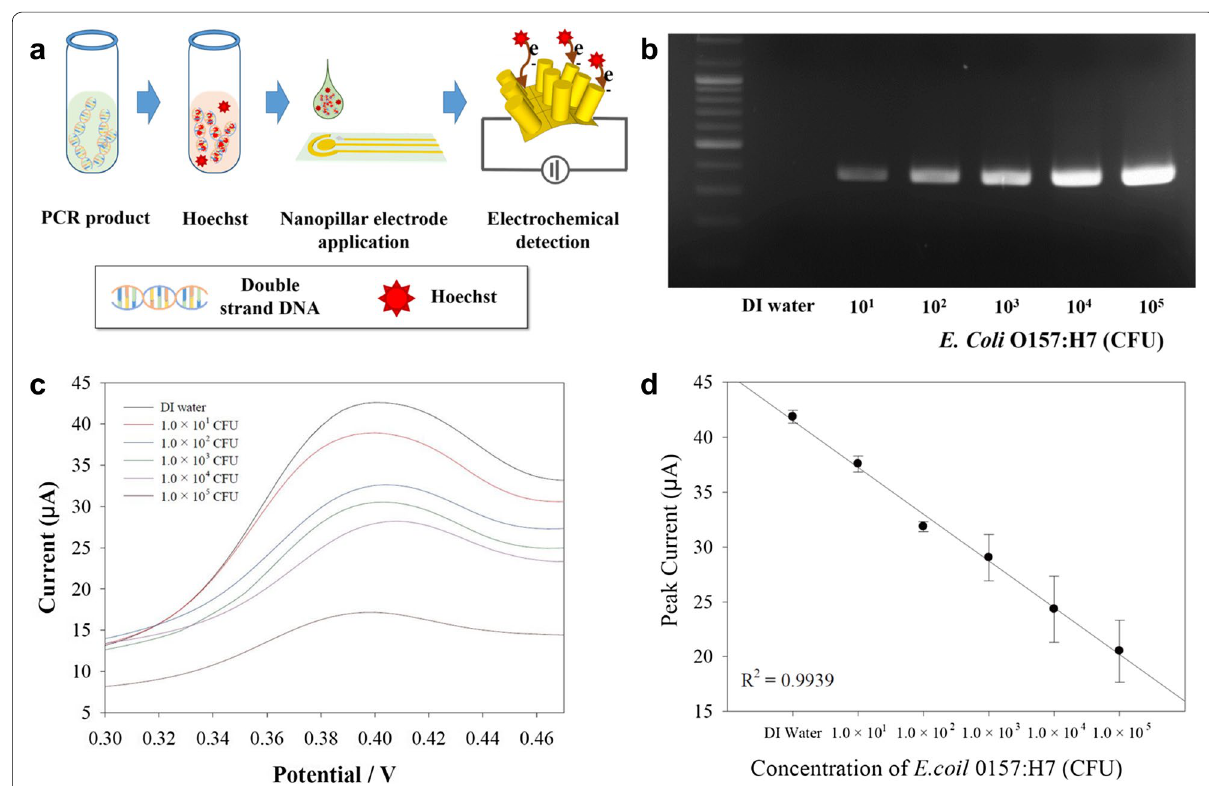
Fig. 3 a Illustration of NPE-based electrochemical evaluation of E. coli O157:H7. b Optical image of gel electrophoresis from the amplified gene of E. coli O157:H7 by conventional PCR. c The voltammogram from each applied test. d Calibration curve of electrochemical analysis of E. coli O157:H7 using the NPE. The same tests were repeated at least three times, and the error bar indicated the signal